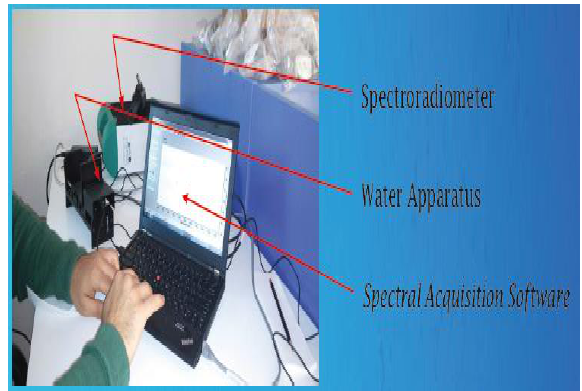
Figure 2. Obtaining the spectras from the water samples